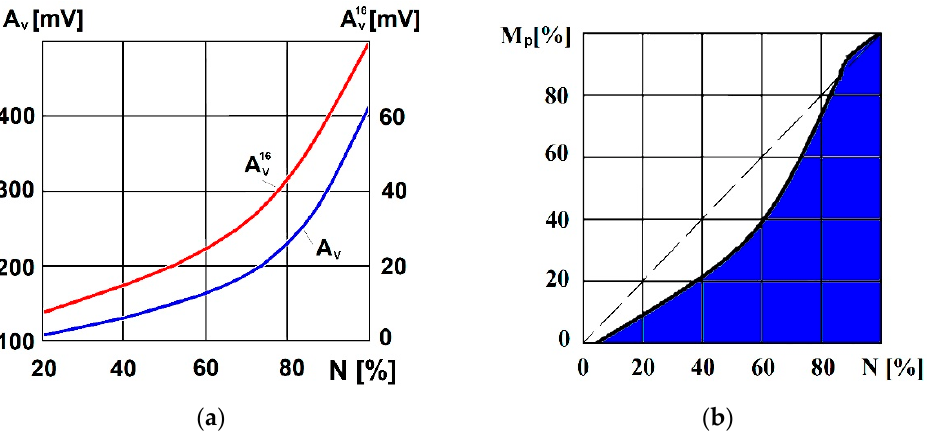
Figure 7. Dependencies of the effective amplitude of the vibroacoustic signal ( a ) and productivity ( b ) from laser power N : A v is a vibroacoustic signal amplitude in wide frequency range; A v 16 is an amplitudes of the signal of 16 kHz octave.